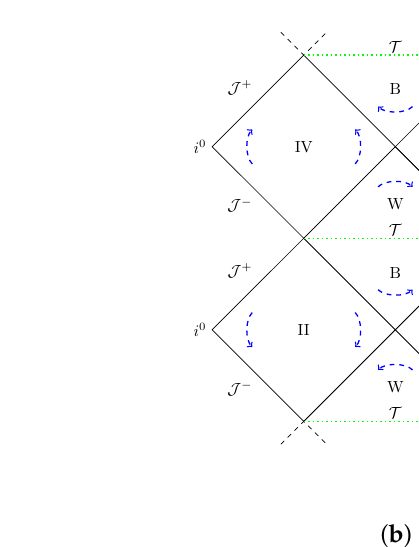
Figure 4. ( a ) LQG extension of the Schwarzschild-interior. In classical GR we only have the lower triangular region that is bounded below by the trapping event horizon T-EH and ends with a future space-like singularity at r = 0. Quantum geometry effects of LQG resolve this singularity and replace it with a transition surface, labeled τ , to the future of which we have an anti-trapped region with a future boundary that constitutes an anti-trapping event horizon AT-EH. Quantum geometry effects are important only in a neighborhood of τ , shown by a shaded (pink) region. ( b ) LQG extension of the Kruskal space–time [18,19]. Quantum geometry effects resolve both black hole and white hole singularities and the quantum corrected LQG space–time extends indefinitely. The central diamond corresponds to panel (a).The dashed (blue) arrows depict integral curves of the Killing vector. Just as in only a part of the full Kruskal space–time is physically relevant for gravitational collapse in classical GR, only a portion of this infinite extension is relevant for the black hole evaporation process (see Figure